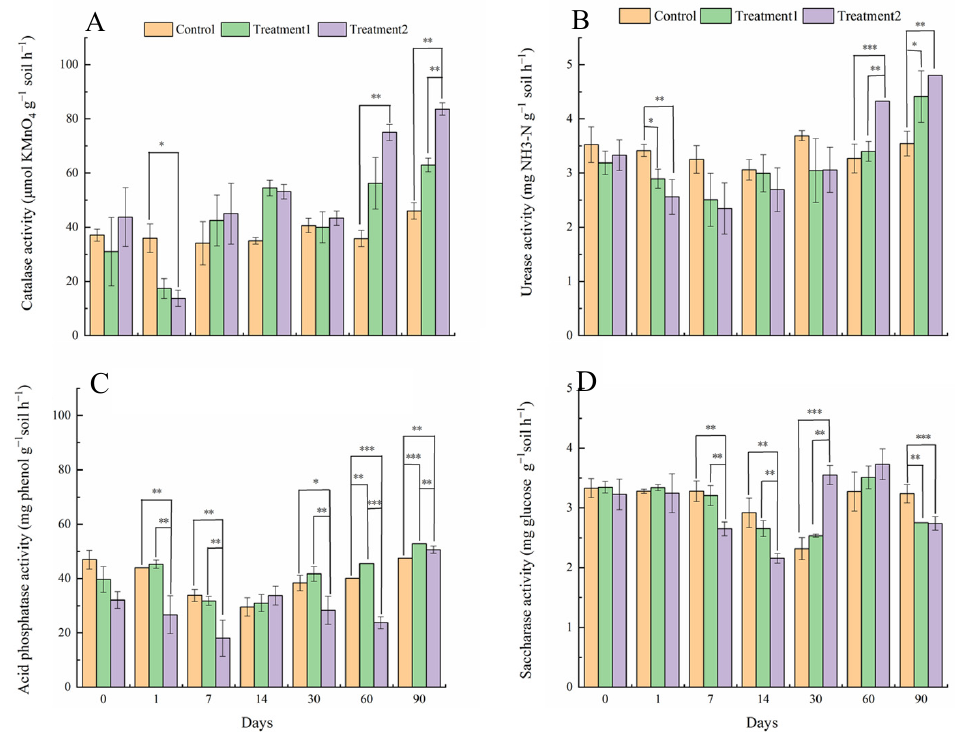
Figure 2. Effect of fomesafen on enzyme activities in soil in the recommended level and twice recommended level group. Data represent the mean ± SD of each soil sample selected at each time point. *, ** and *** represent a significance level of 0.05, 0.01 and 0.001, respectively; without an * indicates that the difference was not significant according to UNIANOVA with Duncan’s homogeneity test. Treatment 1 represents the recommended usage group, and Treatment 2 represents the twice the recommended usage group. ( A ) Catalase; ( B ) urease; ( C ) acid phosphatase; ( D ) saccharase.